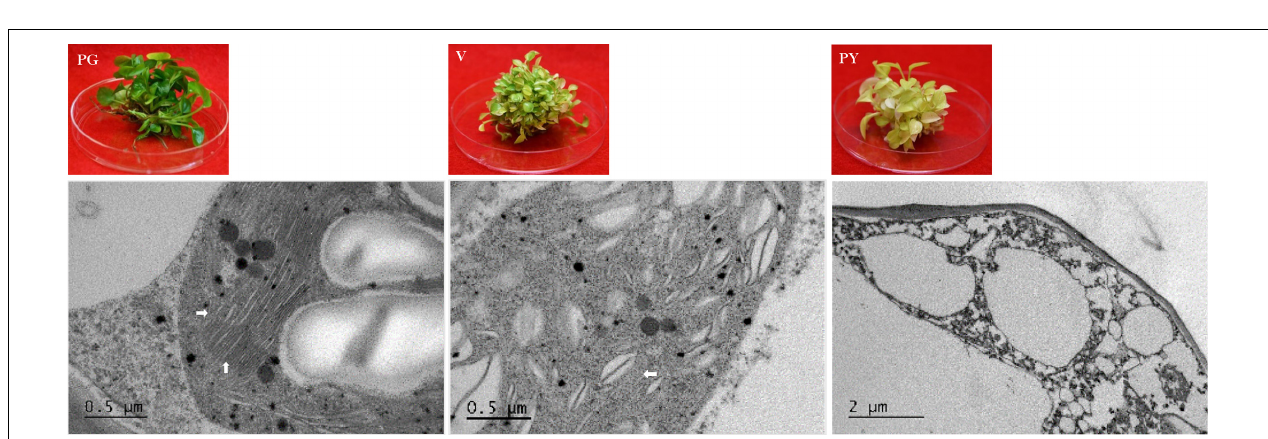
FIGURE 6 | TEM analysis of chloroplast development in ‘Pothos’ wild type leaf cells. (A) ‘Pothos’ green and (B) albino plants from tissue culture (above) and TEM of their leaf cells (below). Red lines indicate the enlarged area. White arrow: detailed thylakoids; P: plastid.